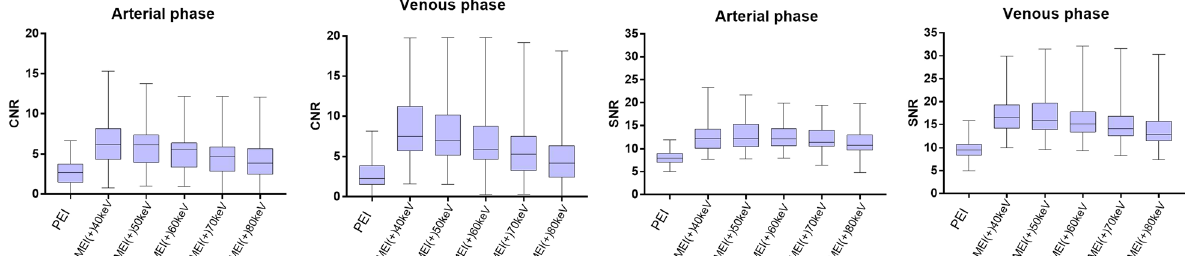
Fig. 3 CNR and SNR for esophageal cancer vs. normal esophageal wall in arterial and venous phase. Increasing CNR or SNR values with decreasing energy levels of noise-optimized virtual monoenergetic images can be appreciated. Asterisks indicate statistically significant differences compared to each other. Besides, CNR or SNR values of PEI were significantly lower than MEI (